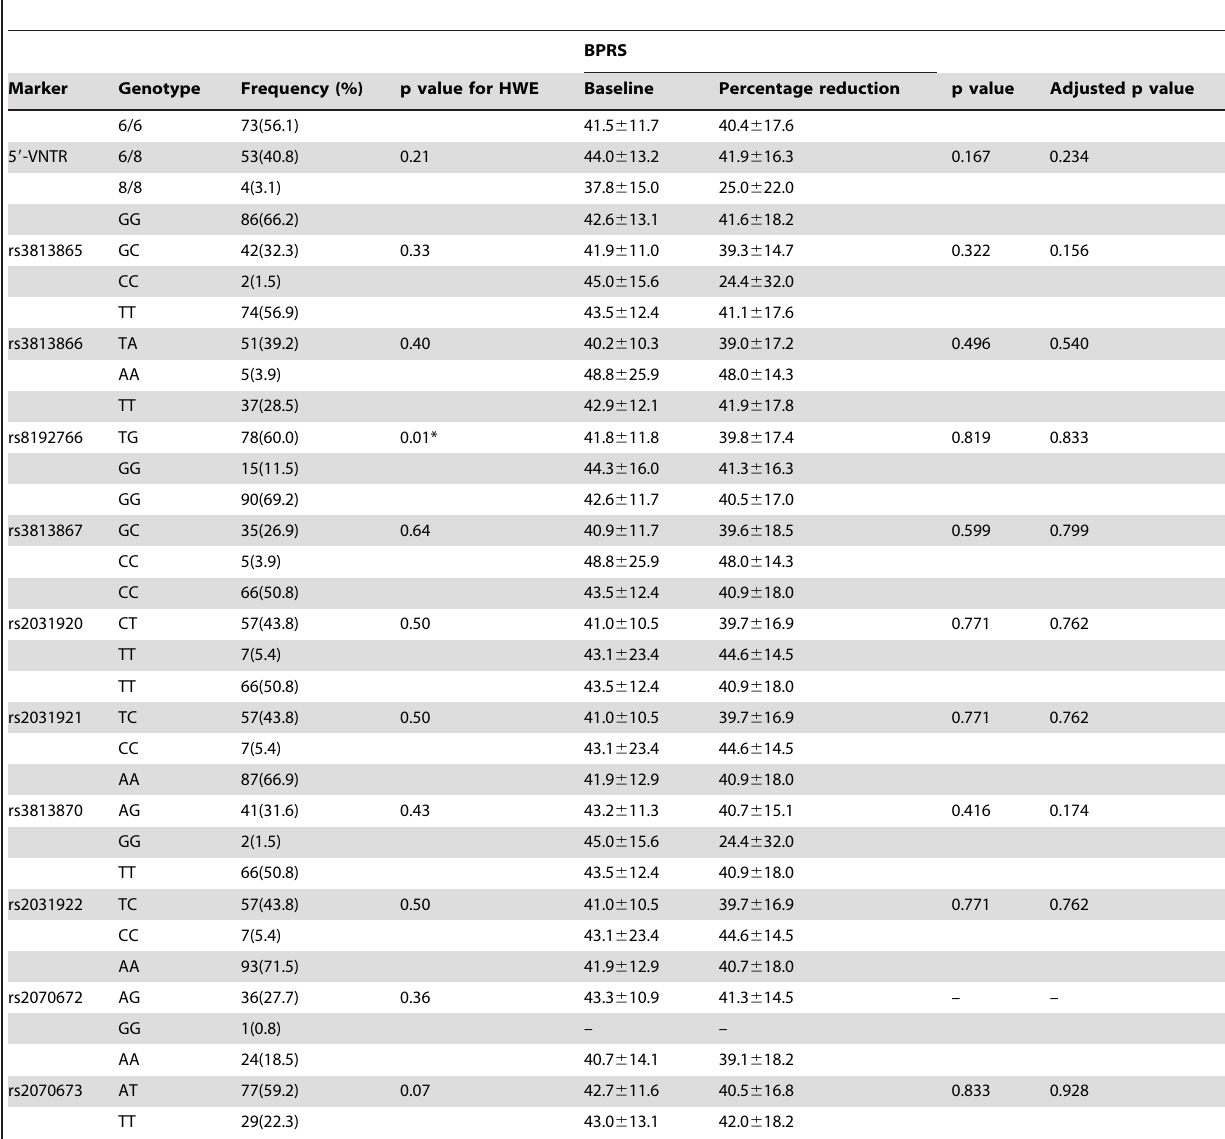
Table 4. Comparison of reduction in BPRS score between genotype subgroups after the 8-week